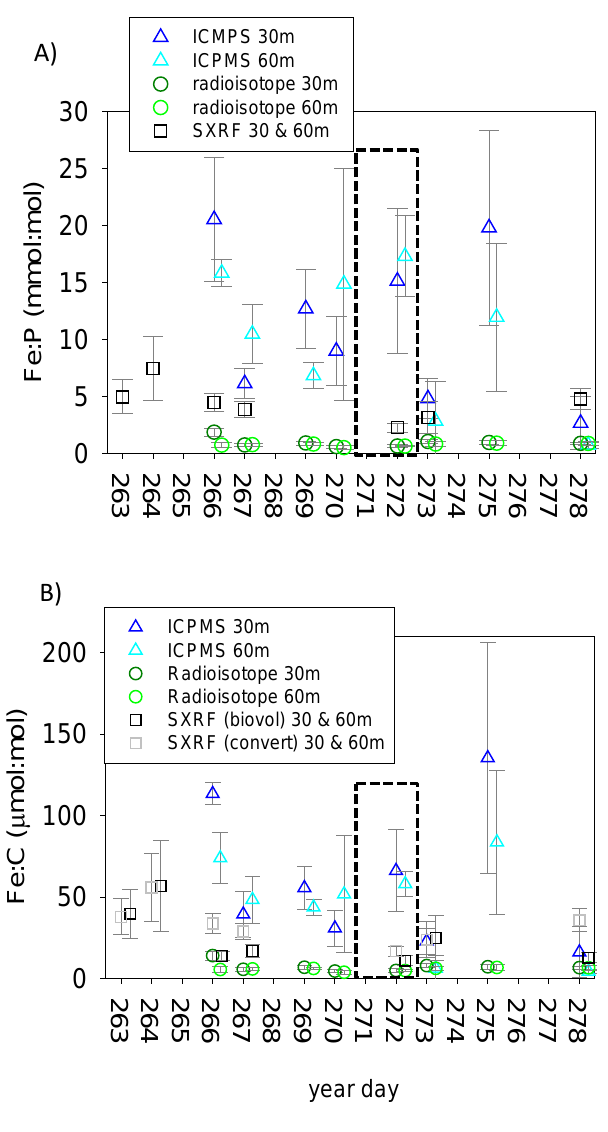
Fig. 5. Comparisons of total particulate Fe:P and Fe:C ratios us- ing the three different analytical methods at 30 m and 60m over the course of the experiment. (A) Fe:P-based comparison for ra- dioisotope uptake (30 and 60m; converted using 133mol C:1 mol P), ICPMS-determined BFe and P (30 and 60m), and SXRF (AN- COVA model results) and (B) Fe:C-based comparison for radioiso- tope uptake (30 and 60m), ICPMS-determined BFe and POC, and SXRF (using both biovolume-based C estimates and conversion from SXRF-determined P to C using 133mol C:1mol P). Error bars for radioisotope- and ICPMS-based quotas represent 1 stan- dard deviation ( n = 3). Error bars for SXRF-based quotas represent standard error. The transition phase of the study is marked by the dashed line rectangle. For viewing clarity, 30 and 60m data, as well as converted and biovolume-based SXRF Fe:C data, are offset by 0.3d.